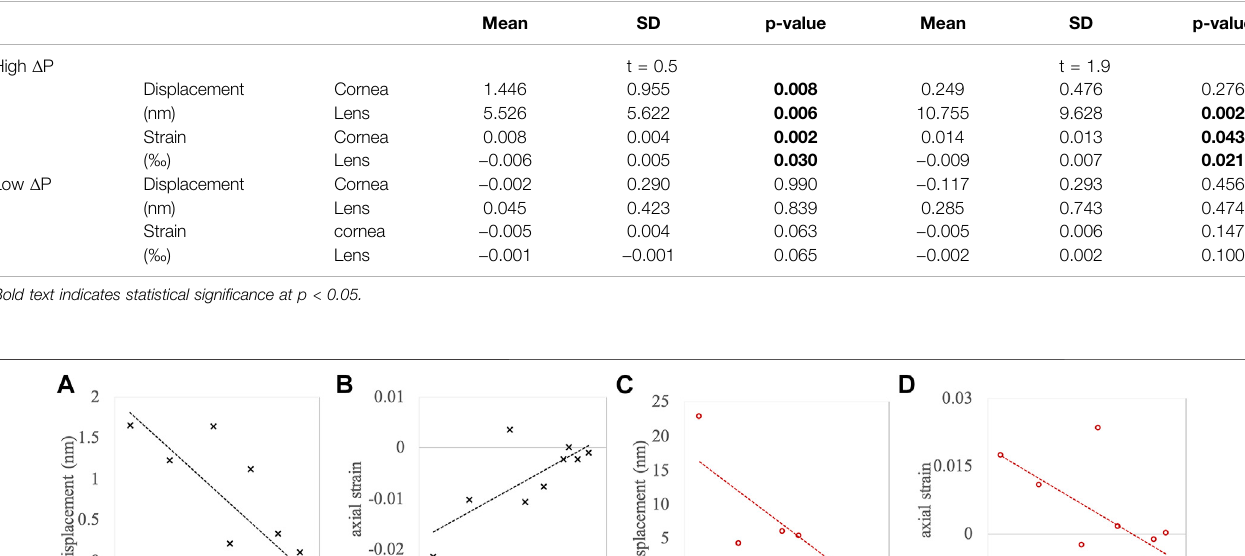
TABLE 1 | Induced deformation 0.5 and 1.9 s after ambient pressure decrease.